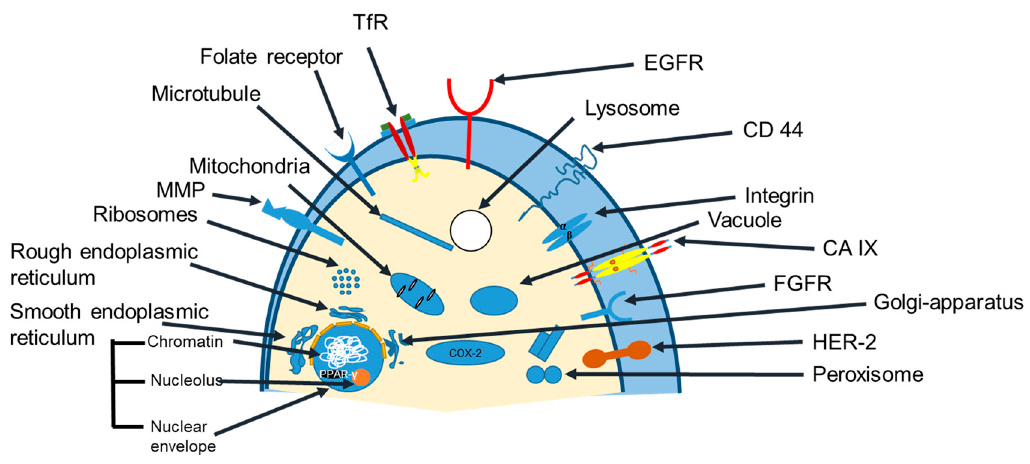
Figure 4. Receptors (intracellular and extracellular) that can be targeted using ligand-targeted liposomes for the delivery of anticancer drugs. Targets could also be specific organelles (mitochondria and lysosomes) [21].